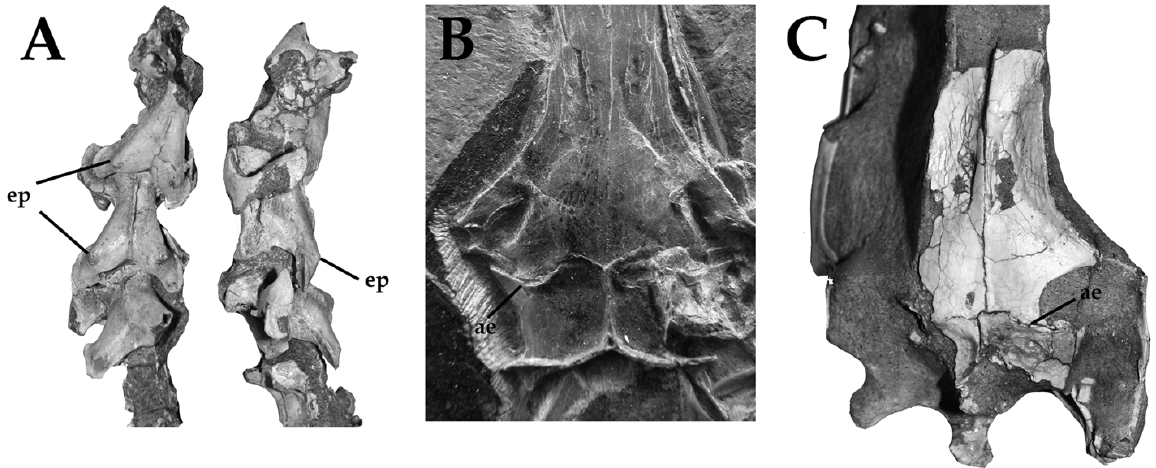
Fig. 5 – A , dorsal and left lateral views of mid-cervical vertebrae of Buitreraptor gonzalezorum (MPCA, 245; holotype); B , dorsal view of skull roof of Sinornithosaurus millenii (IVPP V12811; holotype); C , Dorsal view of skull roof of Buitreraptor gonzalezorum (MPCA, 245; holotype). Scale bar 5 cm. Abbreviations : ae, anterior emargination of supratemporal fossa; ep,